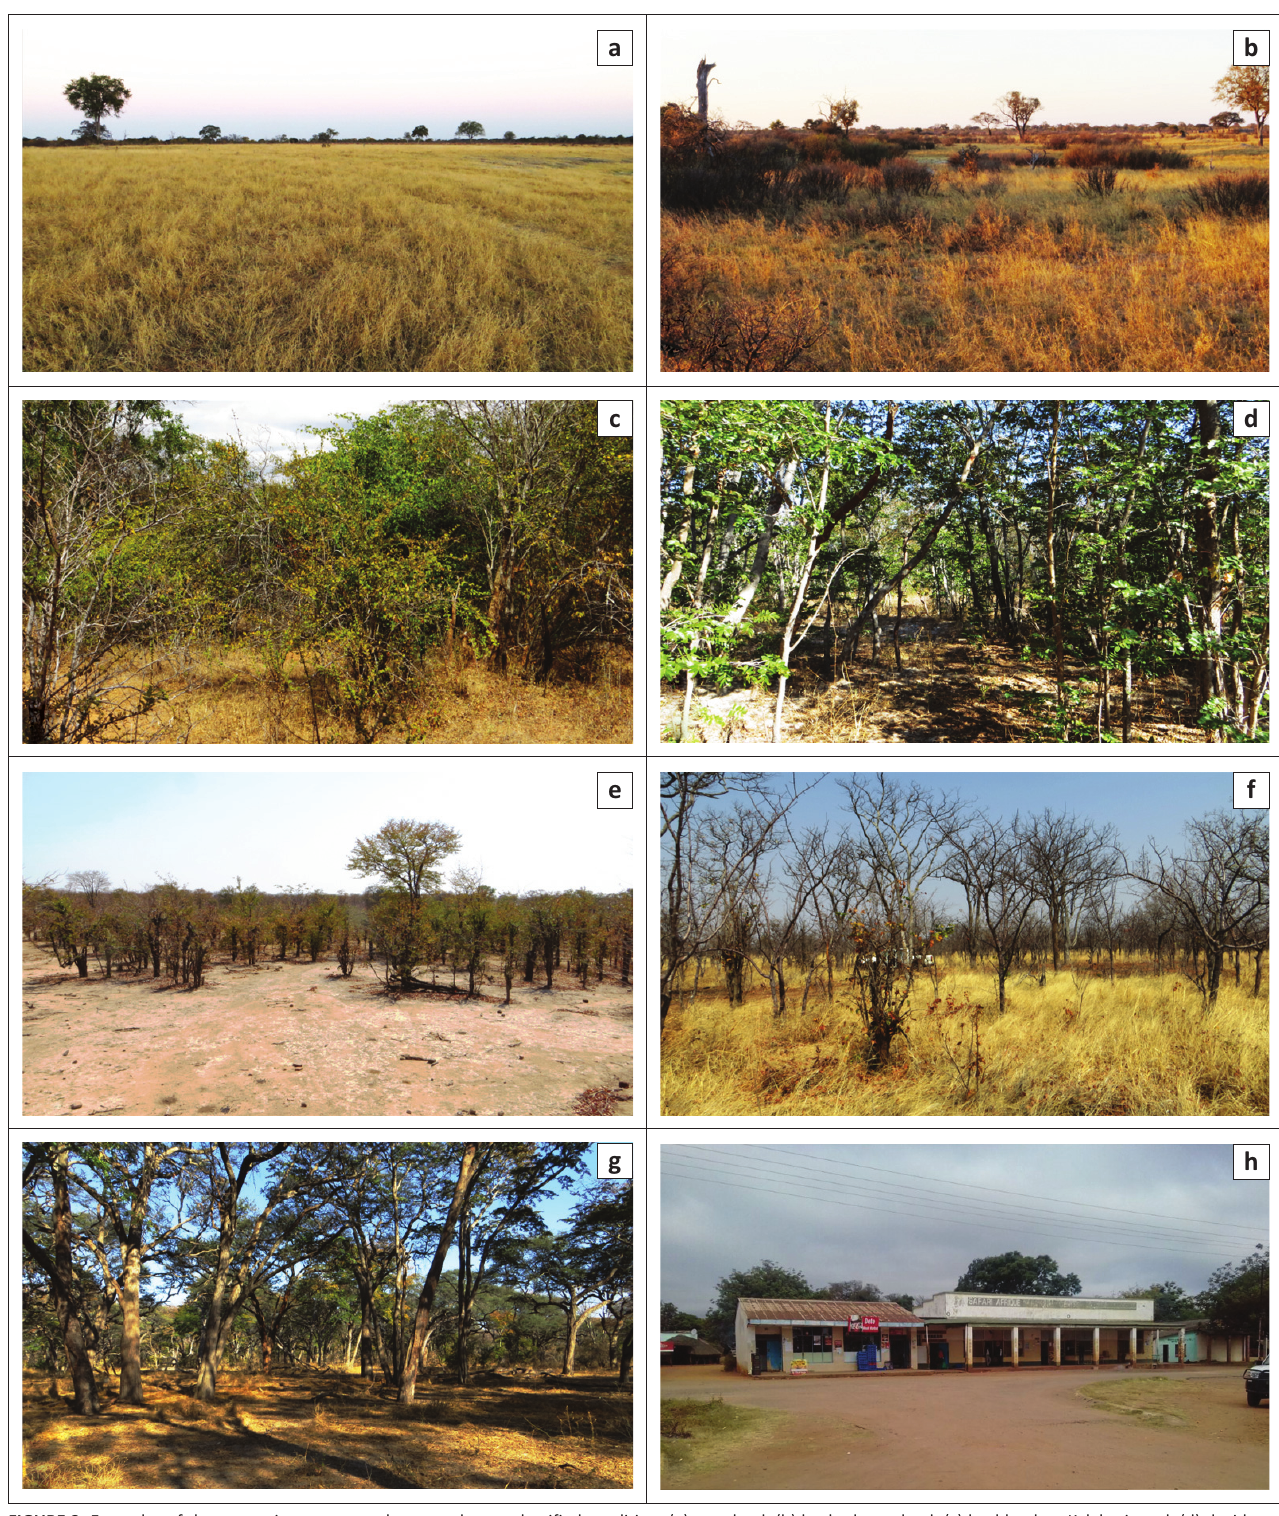
FIGURE 2: Examples of the vegetation structure classes and an unclassified condition: (a) grassland, (b) bushed grassland, (c) bushland on Kalahari sand, (d) deciduous woodland on Kalahari sand, (e) scrubland on basalt, (f) deciduous woodland on basalt, (g) evergreen woodland and (h) buildings in the town of Dete illustrating the unclassified